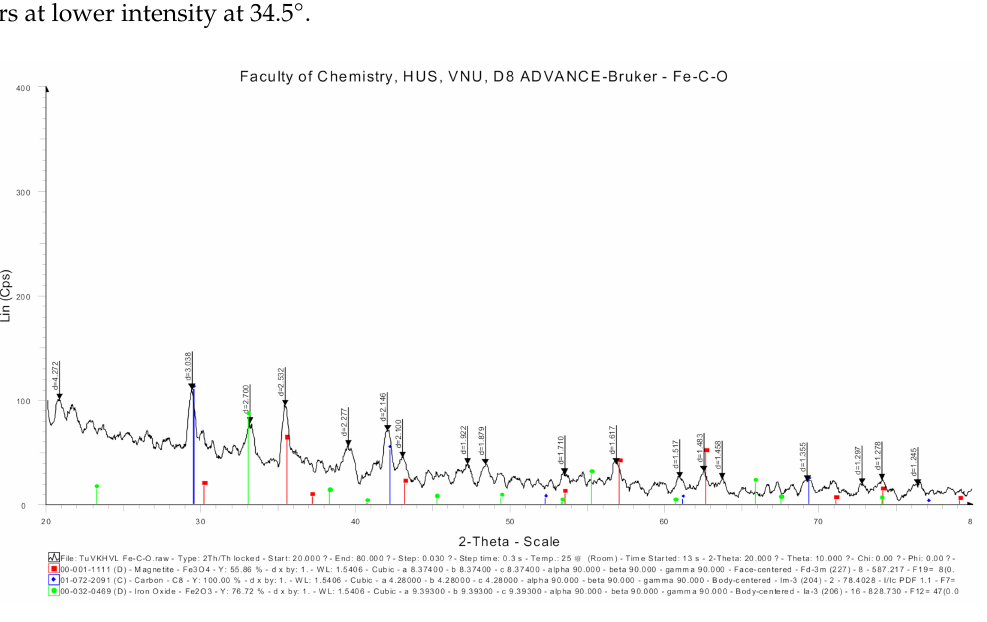
Figure 5. XRD pattern of Fe-C